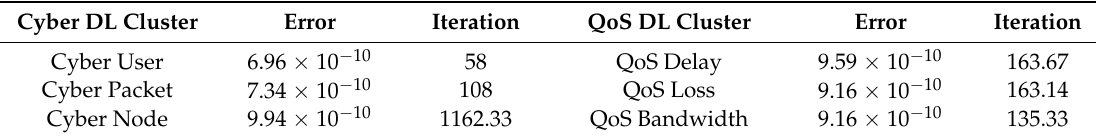
Table 4. Deep Learning Cluster Validation (3 × 3 Nodes).